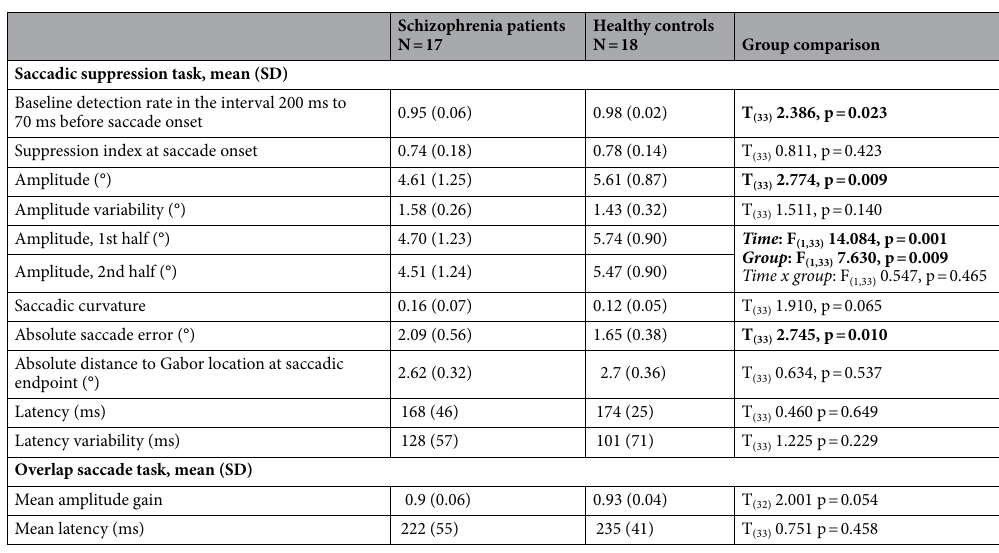
Table 2. Saccade metrics of patients with schizophrenia (N = 17) and healthy controls (N = 18) derived from a saccadic suppression task and an overlap saccade control task. Statistically significant group differences are indicated in